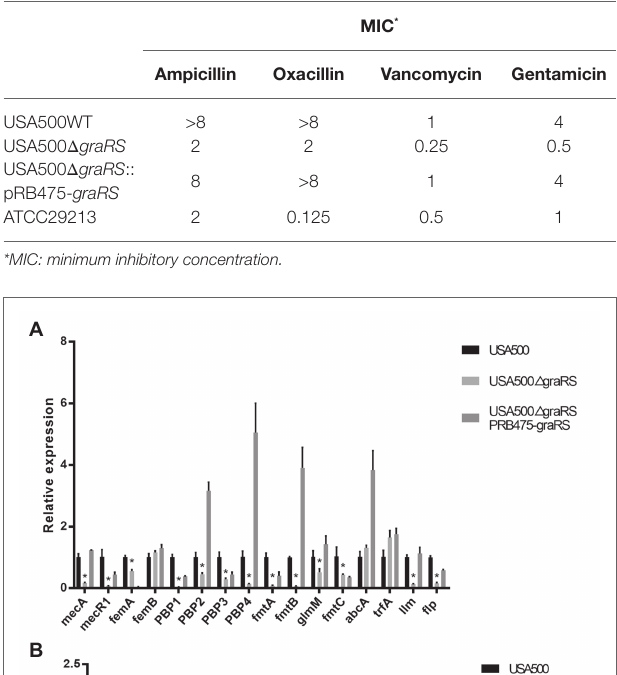
FIGURE 2 | deletion in the USA500 on β -hemolysis on the blood agar at 48 h. (E,F) The microtiter plate assay was carried out to detect the ability to form biofilms of USA500WT, USA500 Δ graRS , and USA500 Δ graRS:: pRB475- graRS strains in TSB supplemented with 1% glucose at 24 h (E) and 48 h (F) . (G) Confocal laser-scanning microscopy (CLSM) was performed to visualize the three-dimensional structure of biofilms formed by the three strains. The bacterial strains were cultivated in TSB supplemented with 1% glucose in glass-bottomed fluorodishes for 48 h. The biofilms were stained with 1 μ M of SYTO9 and 1 μ M of propidium iodide (PI) for 20 min, and then observed by CLSM with a 63× 1.4-NA oil immersion objective. The three-dimensional biofilm images were generated with IMARIS 7.0 software. (H) Epithelial cell invasion assay: Human alveolar epithelial cells A549 infected by USA500 or USA500 Δ graRS at a MOI (multiplicity of infection) of 10:1 were centrifuged at 500 × g for 3 min and then incubated at 37 ° C with 5% CO 2 for 2 h. Then the medium containing 40 μ g/ml lysostaphin and 200 μ g/ml gentamicin was used to kill the extracellular bacteria. The cells were lysed by 0.1% Triton X-100, and the intracellular bacteria were diluted with PBS and plated on TSA plates for counting. (I) Virulence assessment in the Galleria mellonella infection model: A total of 100 healthy G. mellonella larvae were randomly divided into five groups (20 Galleria mellonella larvae/group). Among them, three groups were injected with the bacterial suspension of USA500, USA500 Δ graRS , or USA500 Δ graRS:: pRB475- graRS (10 5 CFU/ml), respectively. Another group was injected with sterile PBS (PBS control). The last group did not receive any treatment (untreated control). The five groups of G. mellonella larvae were incubated at 37 ° C and monitored daily for survival for 5 days (* p < 0.05).